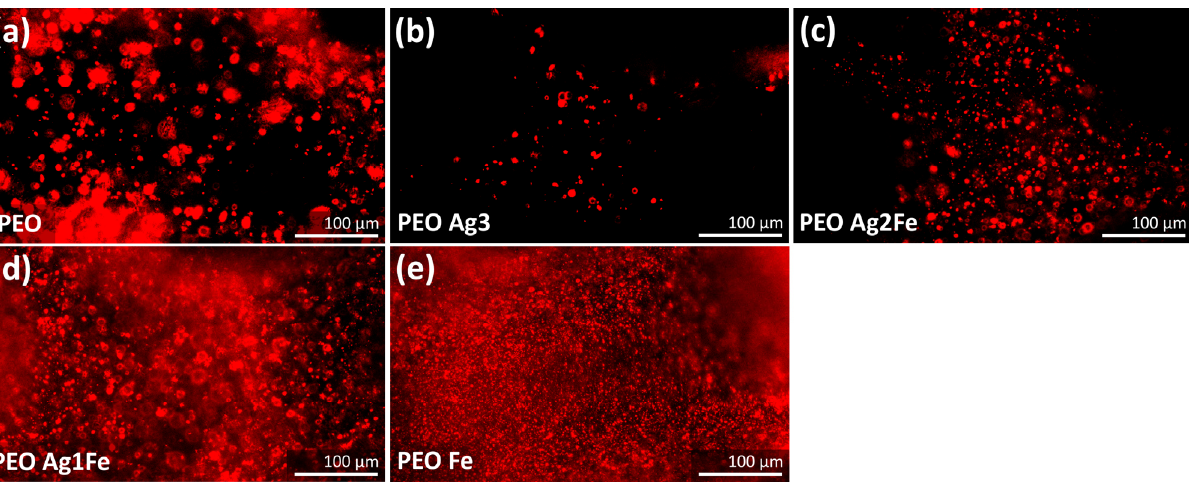
Figure 6. The immunostaining of phospho-CaSR in the preosteoblasts MC3T3-E1 after 14 days of culture on ( a ) PEO, ( b ) PEO Ag3, ( c ) PEO Ag2Fe, ( d ) PEO Ag1Fe, and ( e ) PEO Fe specimens.